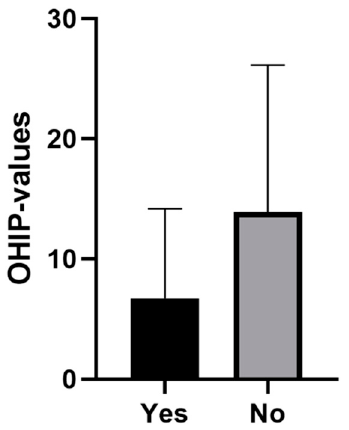
Figure 3. Mean (standard error) for satisfaction with the health